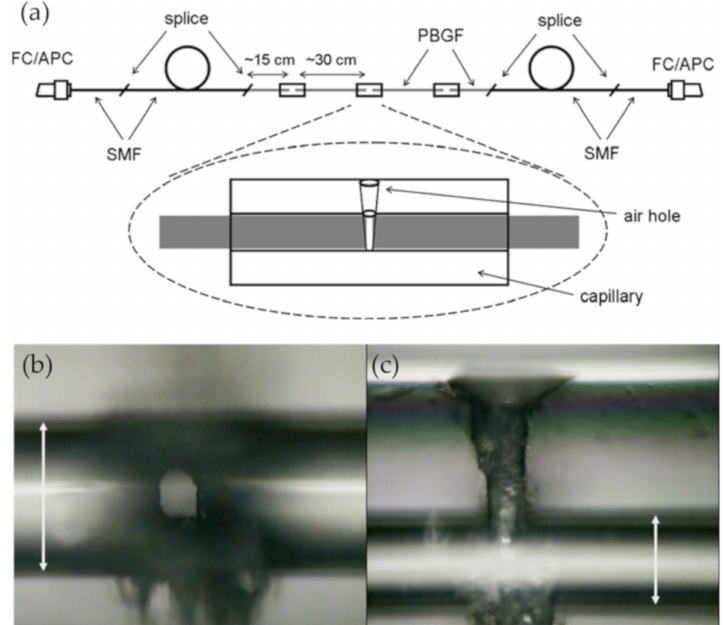
Figure 10. ( a ) Fiber assembly for the gas sensor. FC / APC: ferrule connector / asperity polishing connector. ( b , c ) Images of the laser drilled hole in a glass capillary tube side, from a vertical and a front view respectively